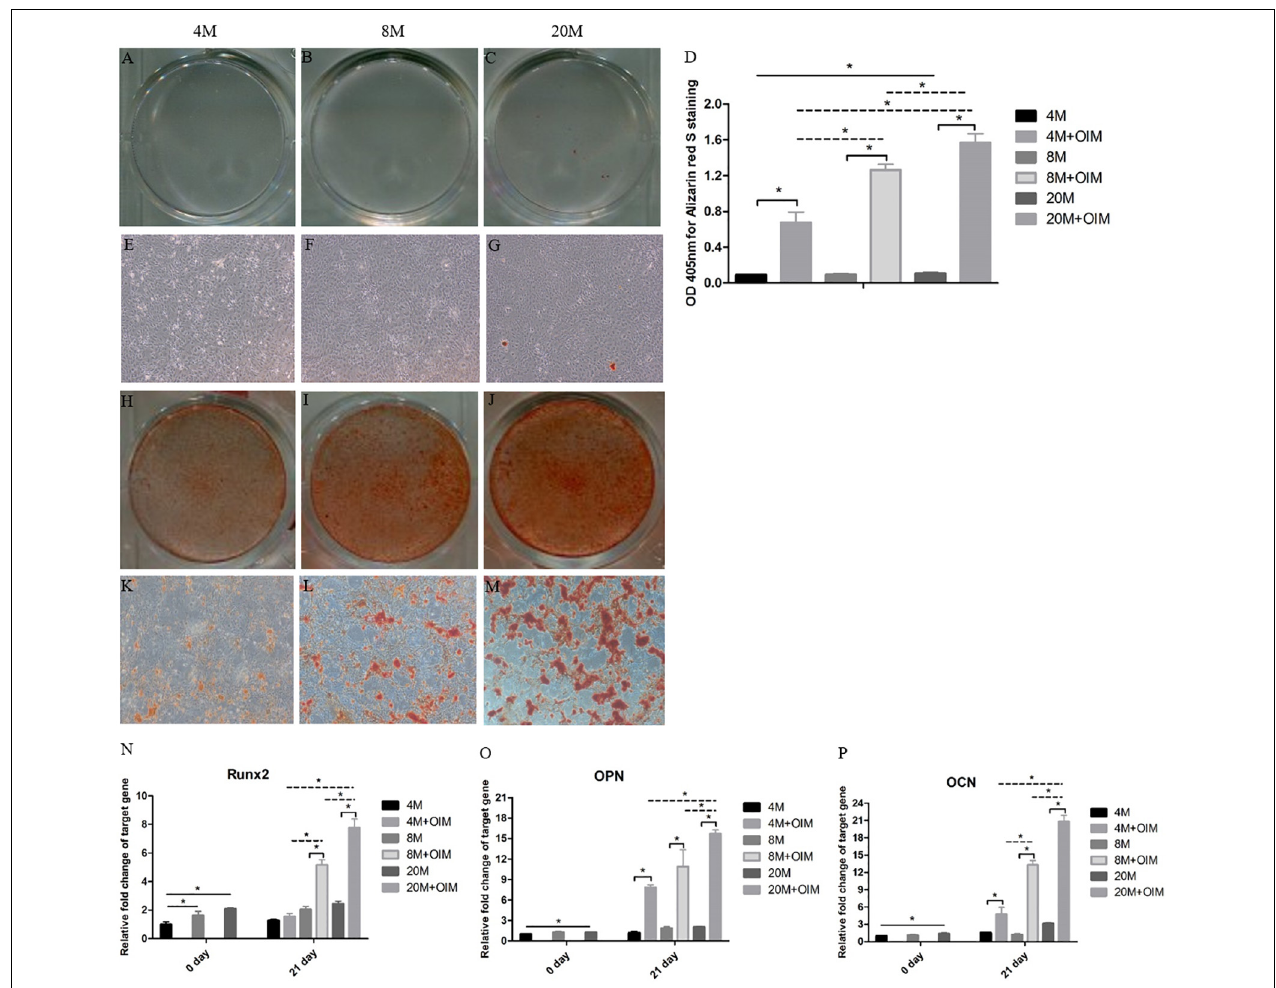
FIGURE 5 | The osteogenic differentiation potential of TSPCs was increased with aging. The osteogenic differentiation potential of TSPCs isolated from ossified tendon aged 4, 8, and 20 M. Obvious calcium deposition was seen in osteogenic induction medium (H–M) , but not in basic medium (A–C,E–G) . (D) Statistical diagrams show the quantization of bound Alizarin red S in TSPCs. (J) Statistical diagram shows the expression levels of osteogenesis-related genes measured by qRT-PCR, including Runx2 (N) , OPN (O) , and OCN (P) . Magnification × 1 (A–C,H–J) and × 40 (E–G,K–M) . ∗ P < 0.05.